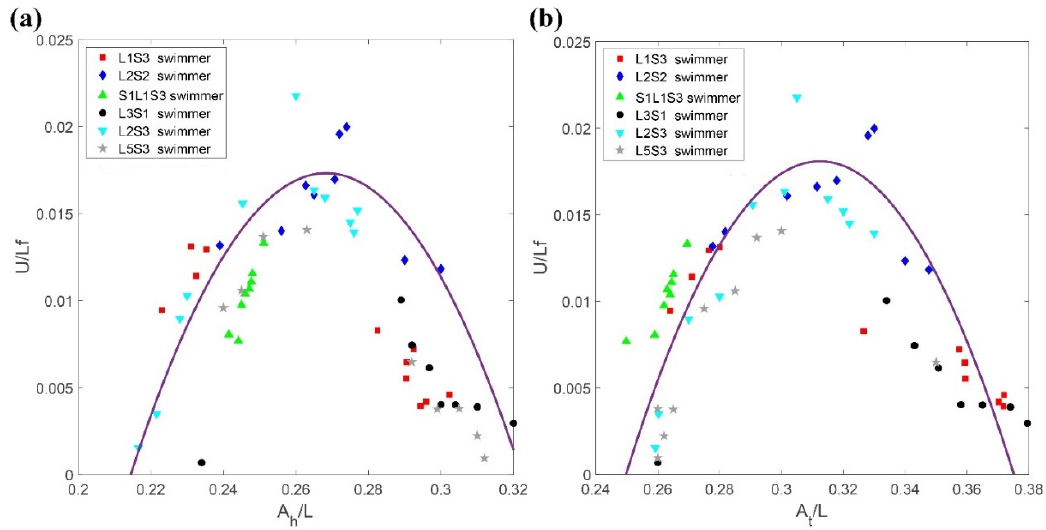
Figure 13. Distribution of the dimensionless swimming velocity in terms of the ratio of maximum amplitude of oscillation for ( a ) the head ( A h ) and ( b ) the tail ( A t ) to the length of the swimmers.